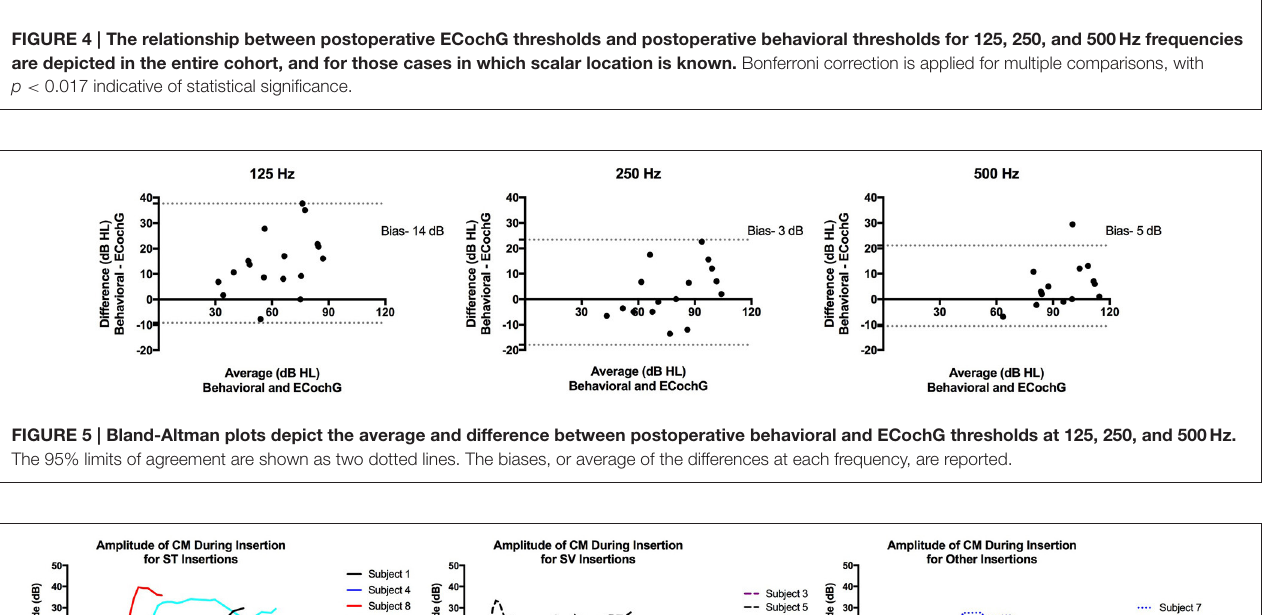
0.06). Further, the mean